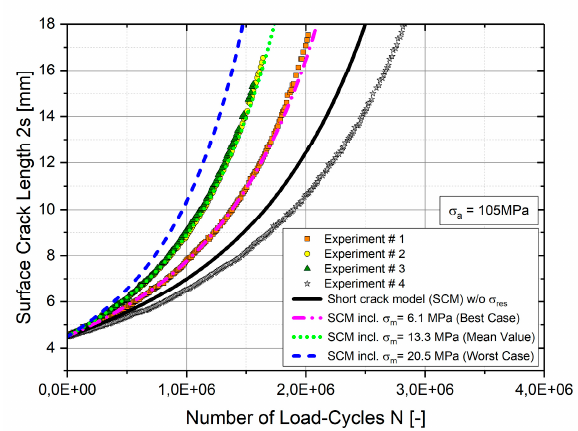
Figure 11. Comparison of analytical assessments and rotating bending experiments #1–#4.